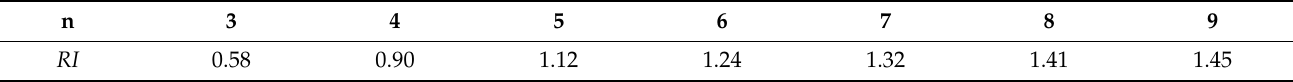
Table 3. Random consistency index ( RI )